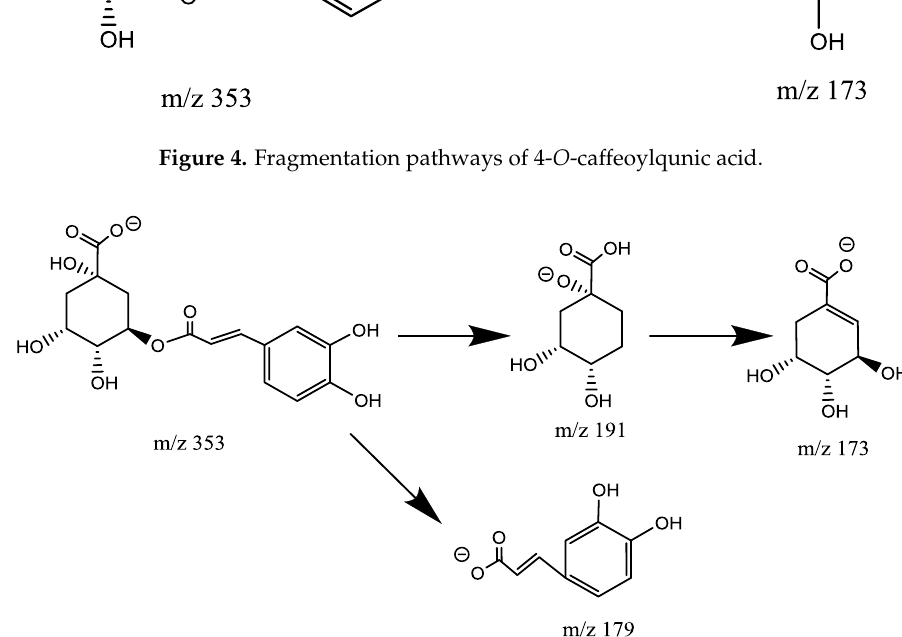
Figure 5. Fragmentation pathways of 3- O -caffeoylqunic acid.